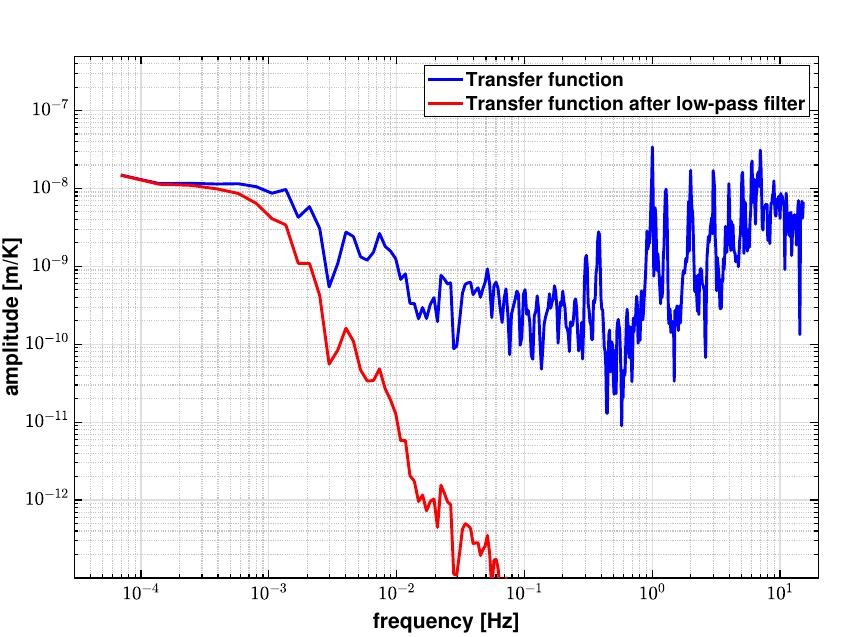
Figure 11. Transfer function between the displacement and temperature measurements before and after applying a 1 mHz low-pass filter. The amplitude of the transfer function is attenuated by a low-pass filter in the frequency regime where the correlation is